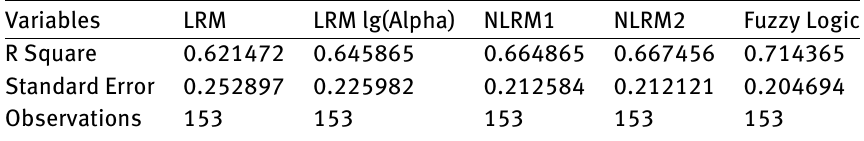
Table 9: Comparison of regression models vs. fuzzy logic model. Variables LRM LRM